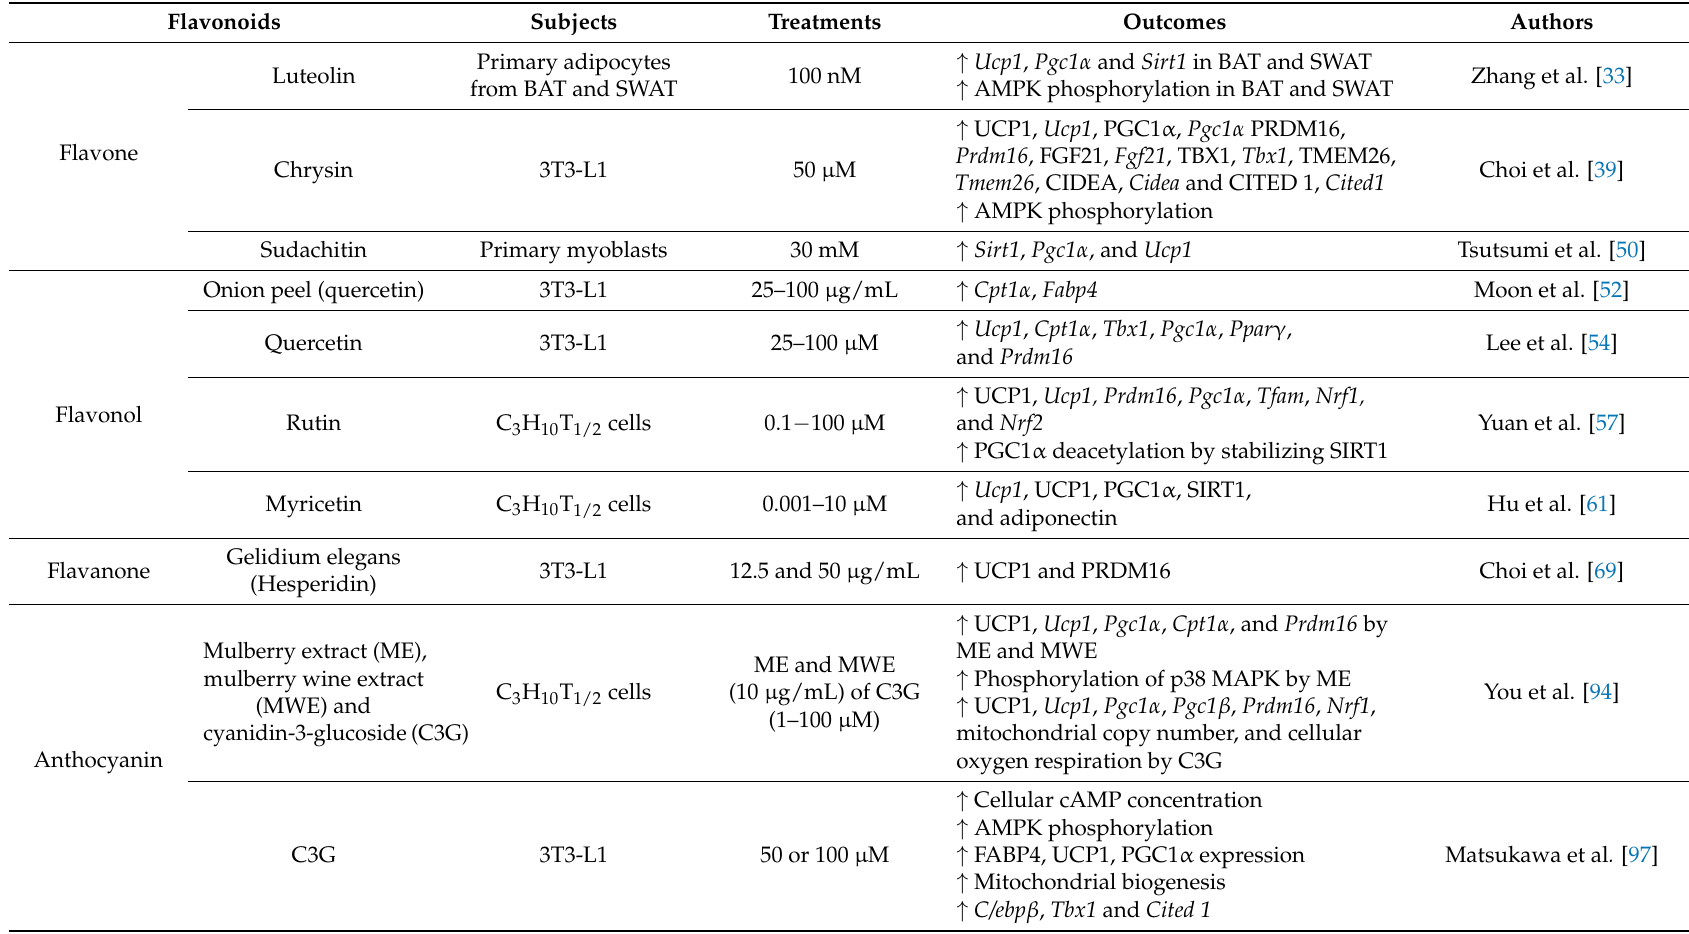
Table 2. In vitro evidence for increase of non-shivering thermogenesis by